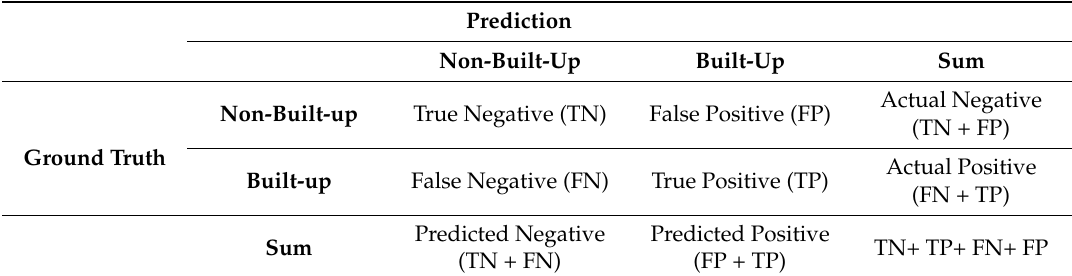
Table 4. The representation of the confusion matrix for the test samples.